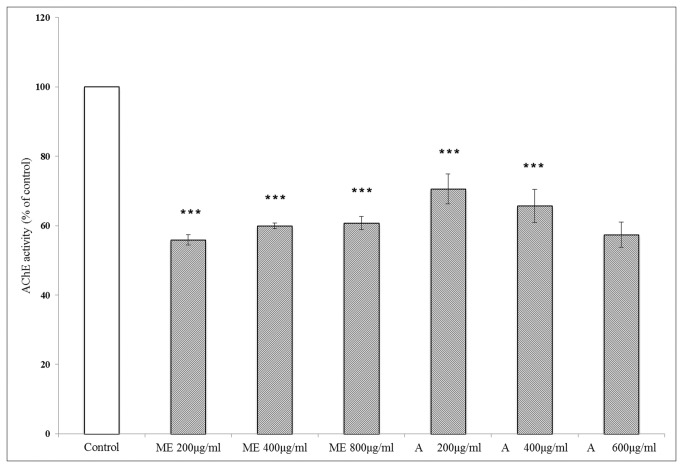
Effects of ME on AChE activity.AChE activity was determined in SK-N-SH cells treated with ME or Donepezil (Aricept®) (A) at different concentration as stated on the X-axis for 24 h. The activity was measured using Amplex® Red Acetylcholine/Acetylcholinesterase Assay Kit and expressed as percentage compared to untreated cells. Data were reported as Mean ± SEM (n=3 independent experiments for each bar). *** P < 0.001 compared to untreated control.